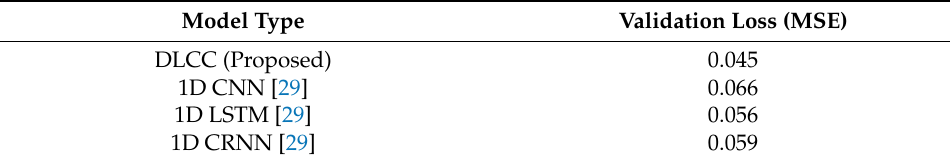
Table 5. Comparison of results obtained from different DL methods.